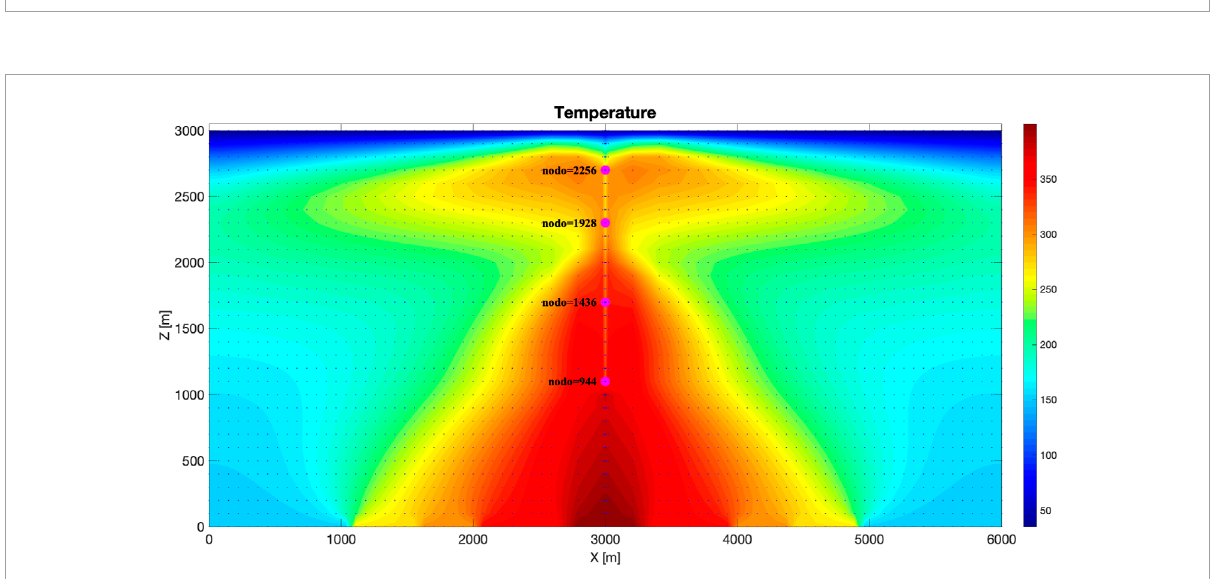
FIGURE 10 Temperature field in the Phlegraean Fields with the DBHE in service (65